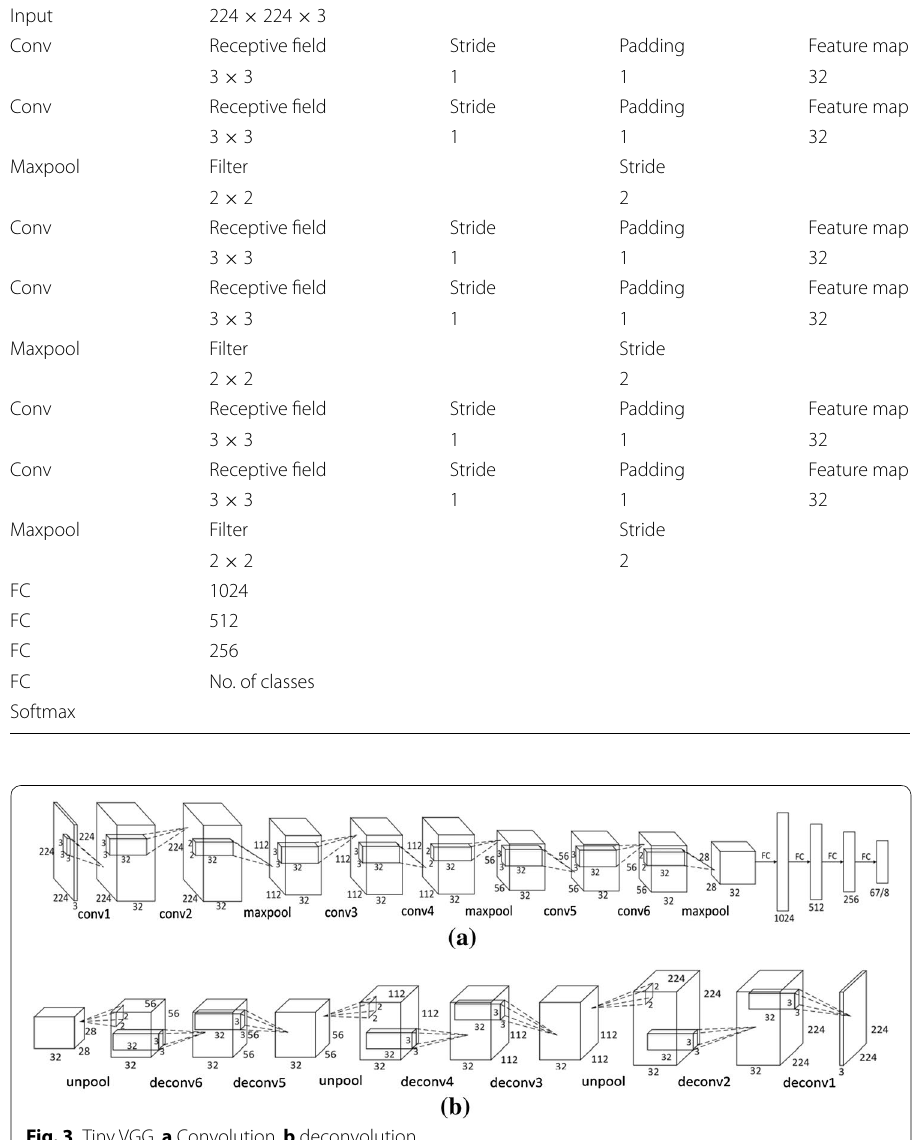
Table 1 The tiny VGG ConvNet configuration